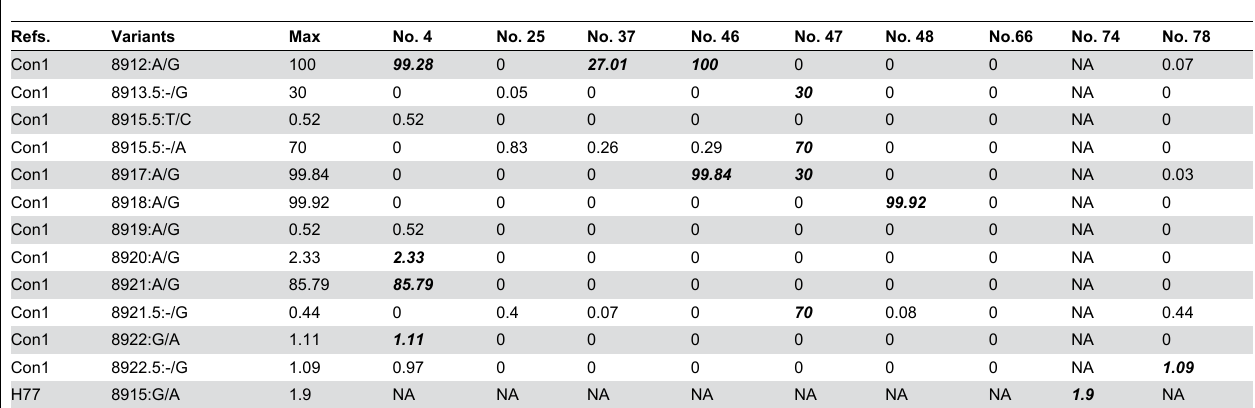
Table 4. Analysis of nucleotide sequence variations (%) in MGB probe segments by ultra-deep sequencing.